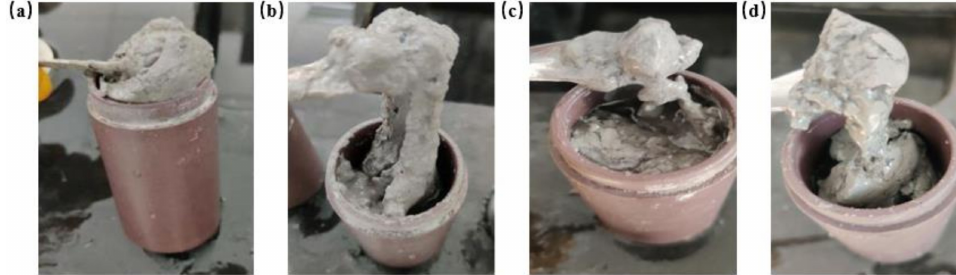
Figure 3. Gelation effect of gel system in salt water: ( a ) 1/3 volume salt water; ( b ) 2/3 volume salt water; ( c ) 1/3 volume gel; ( d ) 2/3 volume